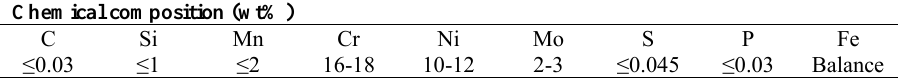
Table 1. Chemical compositions of atomized 316 stainless steel